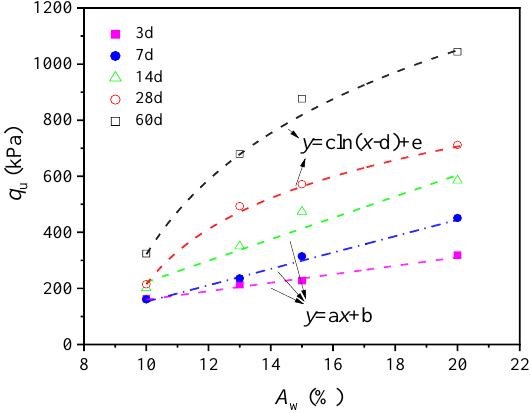
Figure 1. Relationship of q u - A w ( T = 18 °C, w = 1.5 w L , C o = 3.7%).